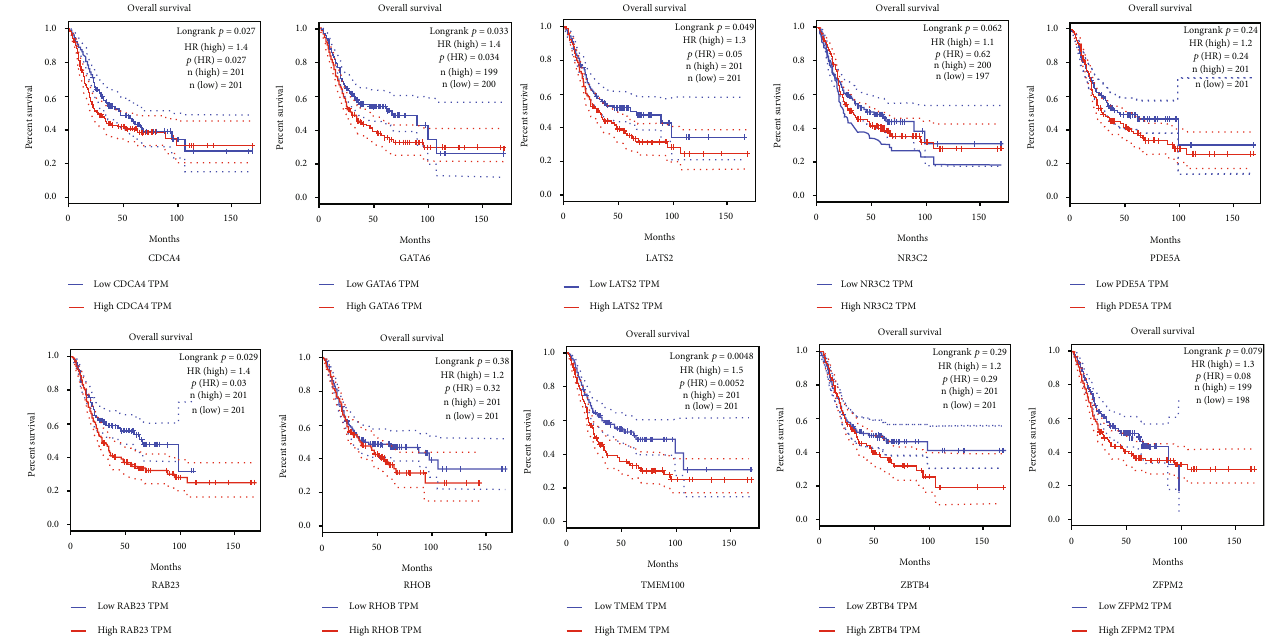
Figure 10: Results of the overall survival analysis of the top 10 hub genes in bladder cancer. The signi fi cant di ff erence was under the condition of P value <